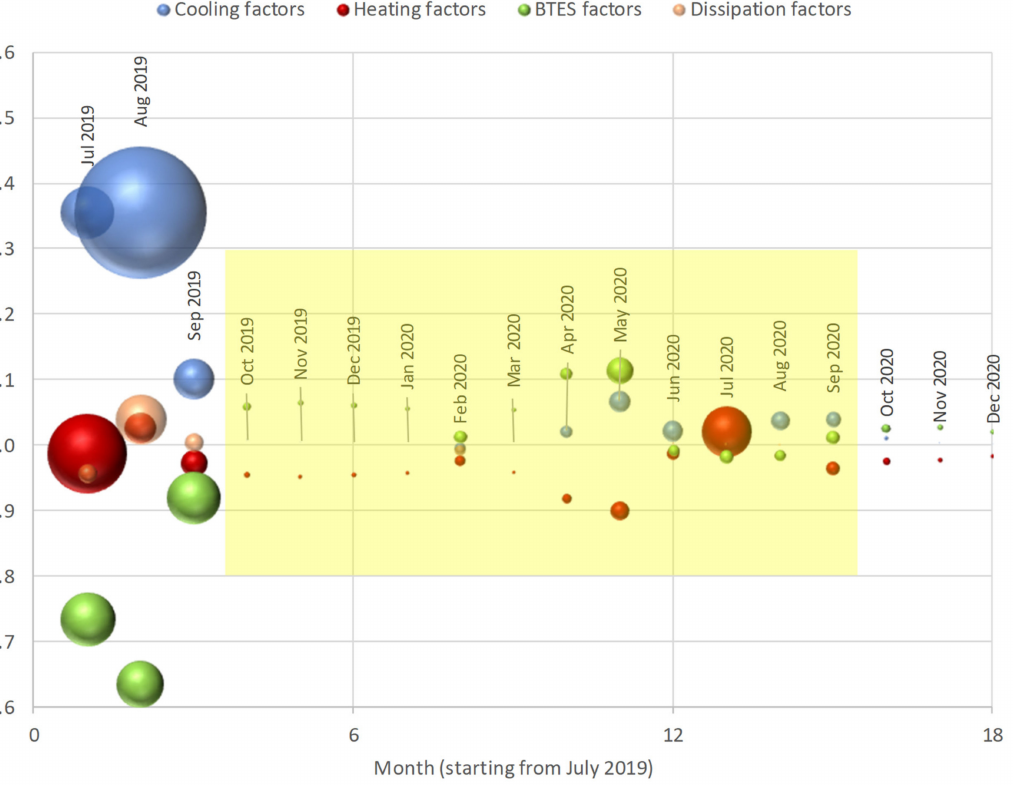
Figure 9. Uncertainty factors and standard deviation (proportional to the diameter of the